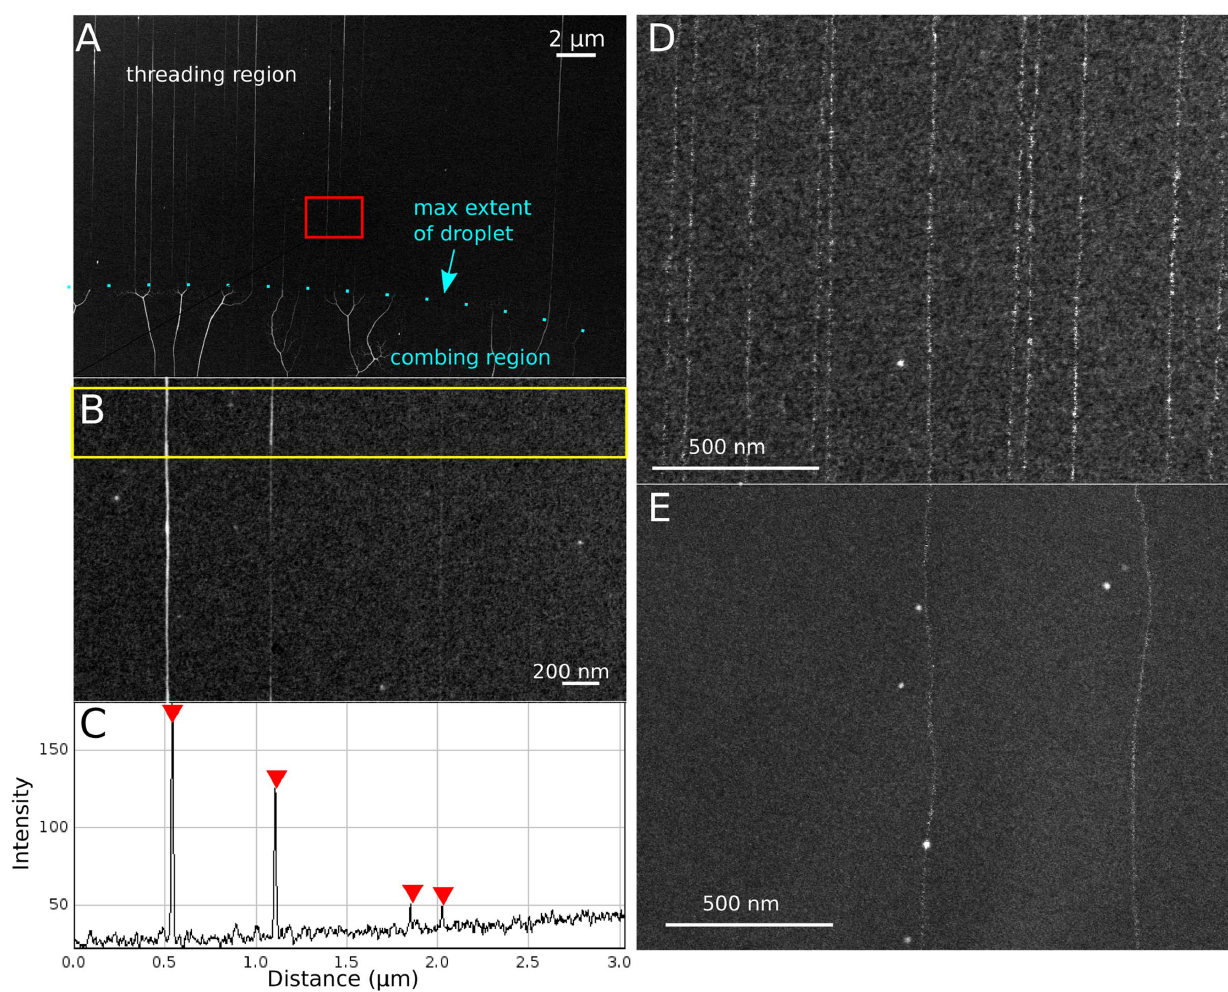
Figure 4. SEM characterization of threaded DNA. All images were taken on a Hitachi S-5500 high-resolution transmission SEM ( , 1 nm resolution), operated at 30 kV, with 50 m A maximum post-flash current. ( A ) Synthetic ssDNA modified with EM-dense labels to enhance contrast against 5 nm thick semiconductor support films. The deposition pattern indicates the behavior of DNA under the action of a receding meniscus compared to the molecular threading process. ( B ) High resolution image of a section of four deposited threads ((A) – red box). ( C ) Intensity profile for a cross section of ((B) - yellow box). The non-homogeneous contrast between threads is likely explained by variability in the number of ssDNA molecules making up each thread, while non-homogeneous contrast between different regions of the same thread is likely explained by secondary structure. ( D & E ) Comparison between (D) molecular threading and (E) molecular combing of synthetic ssDNA, modified with a thymidine-specific label osmium 2-2 9 -bipyridine (osbipy), onto 5 nm thick amorphous Si substrates, with contrast around strand backbone enhanced for publication clarity. Figure 3A ), where the intensity profile from the fluorescent image is superimposed onto interval markers representing the pro- grammed thread spacing of , 1 m m: